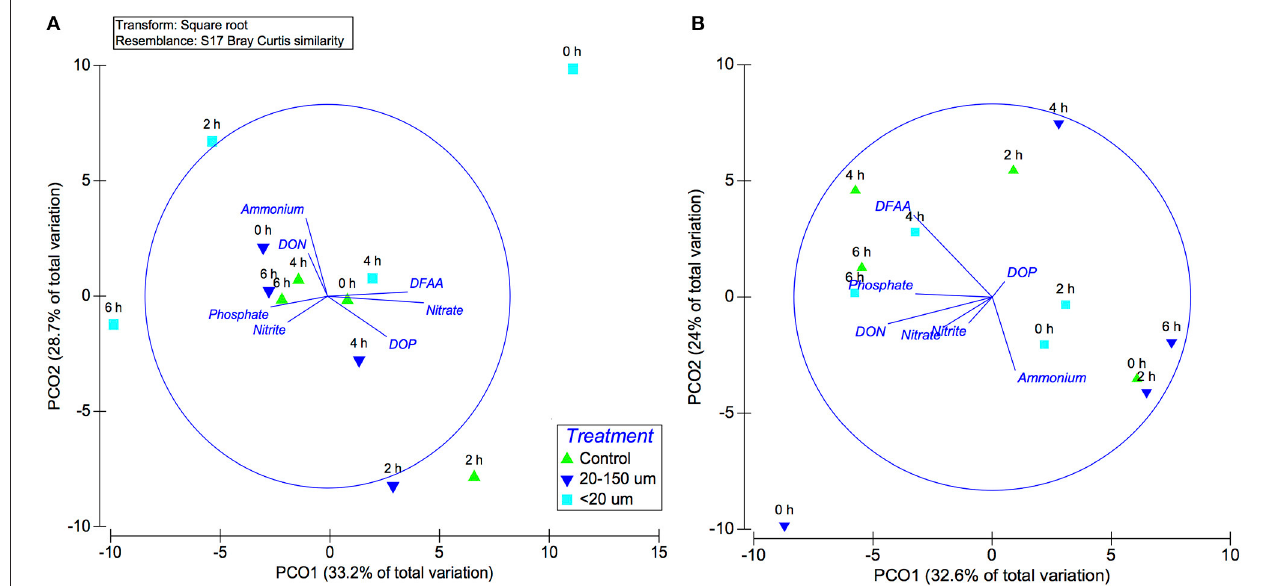
FIGURE 11 | Principal coordinate analysis (PCA) based on Bray–Curtis similarity for the active bacterial community structure, at the order level, for different treatments and the control. (A) Late summer and (B) spring. Vectors indicate the best environmental variables (normalized transformed) correlated with ordination coordinates and vector lengths correspond to the correlation